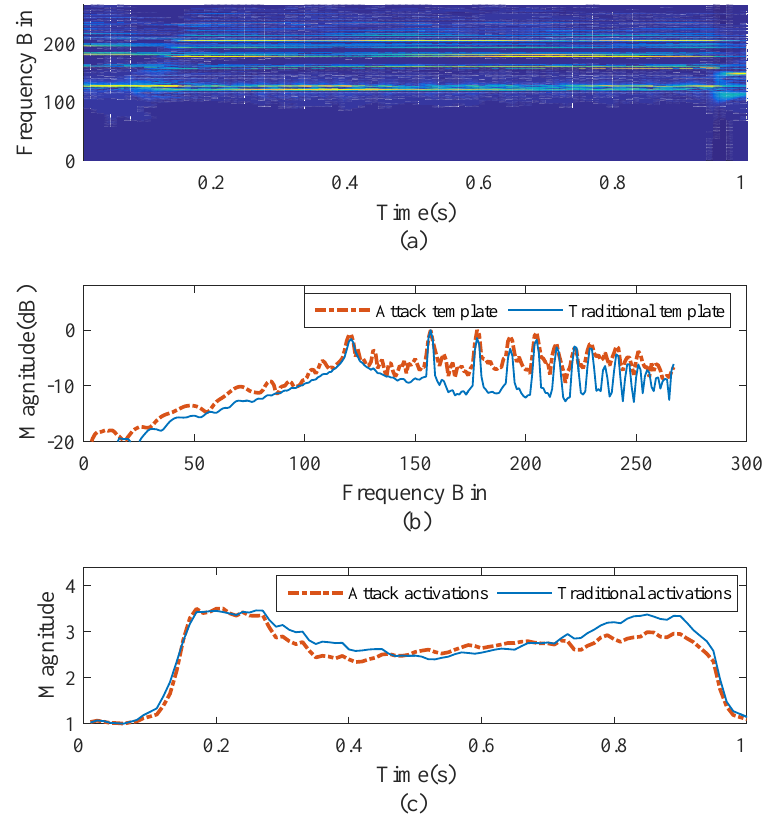
Figure 4. An illustration of note verification: ( a ) a spectrogram excerpt used for NMF; ( b ) the attack templates and traditional templates; ( c ) the attack activations and traditional activations in